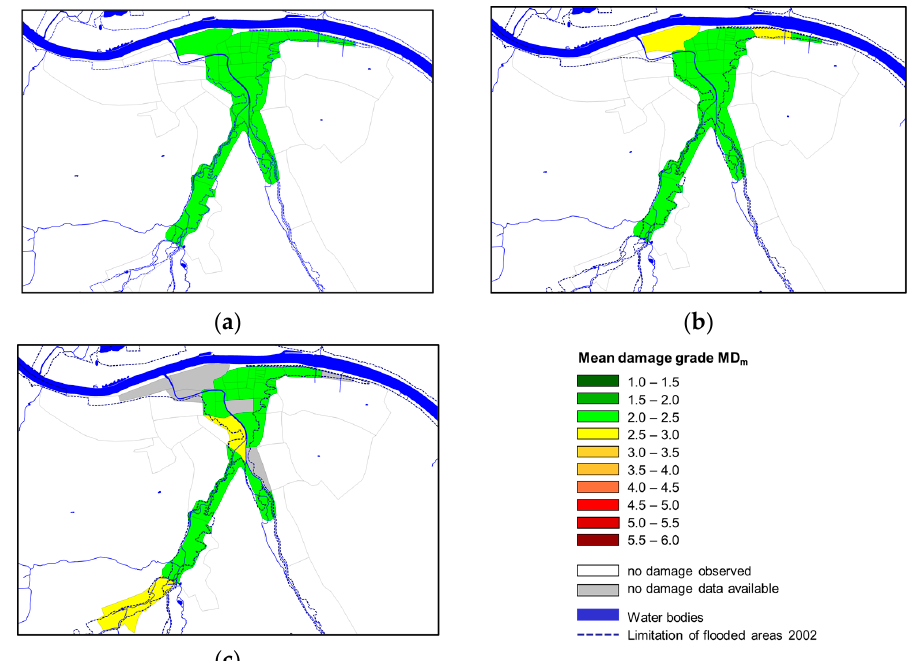
Figure 14. Comparison of the calculated mean damage grades ( MD m,calc ) in the land-use areas and the observed damages ( MD m,obs ) in the Freital investigation area: ( a ) calculated mean damage grades ( MD m,calc ), Level I; ( b ) calculated mean damage grades ( MD m,calc ), Level II; ( c ) observed mean damage grades ( MD m,obs ).